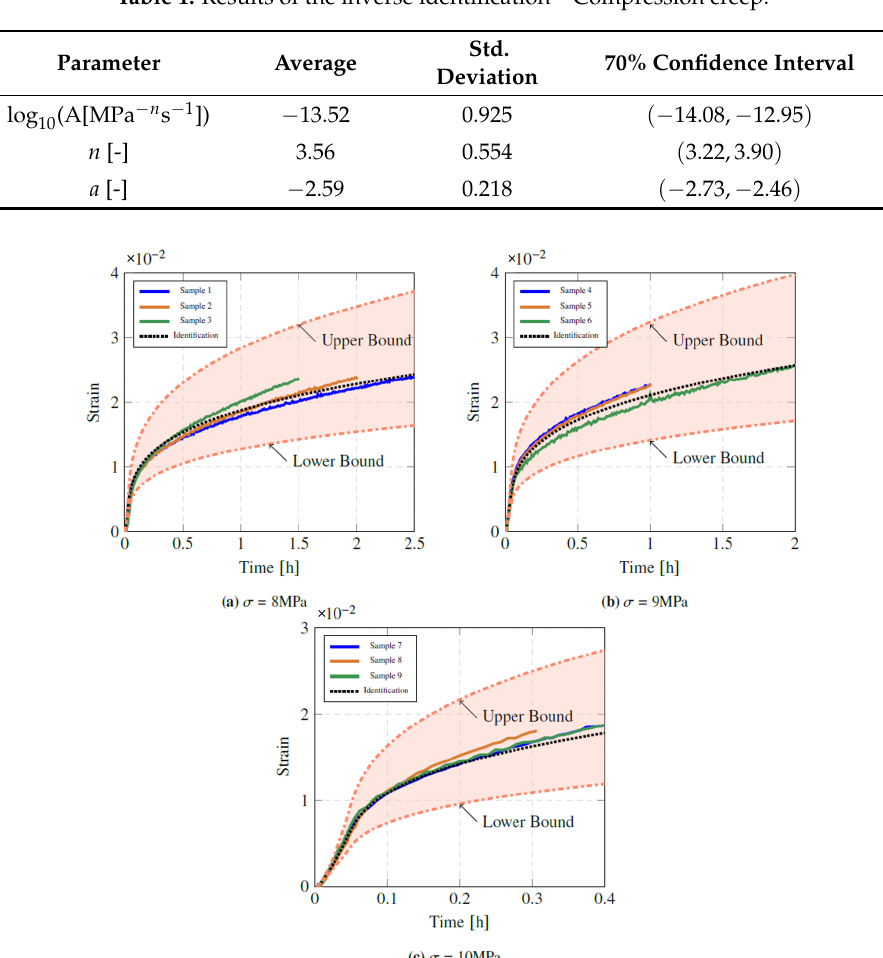
Table 1. Results of the inverse identification—Compression creep.